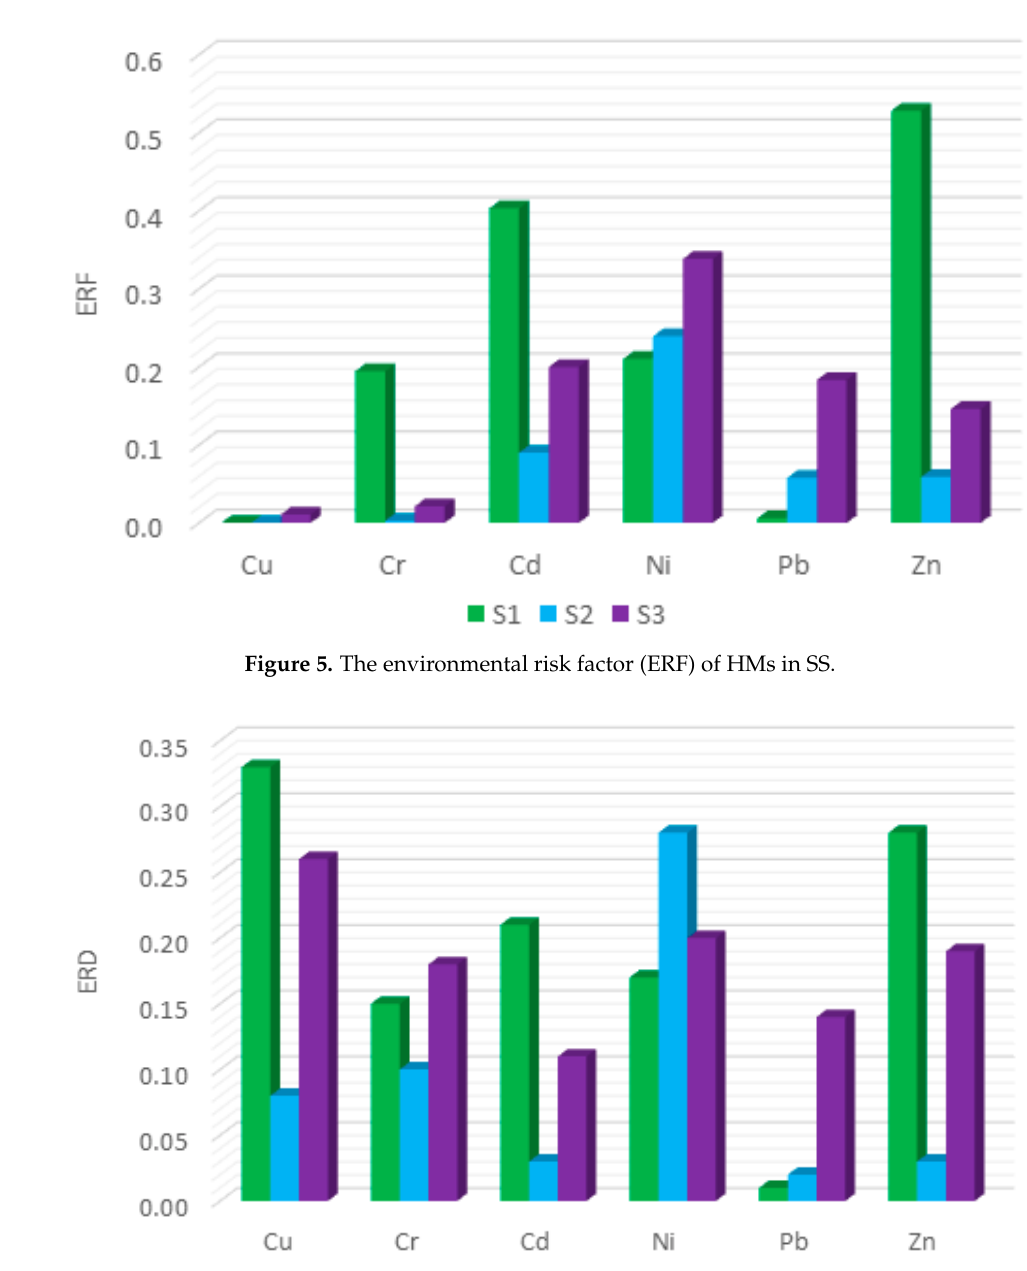
Figure 6. The environmental risk determinant (ERD) indicator of HMs in SS.